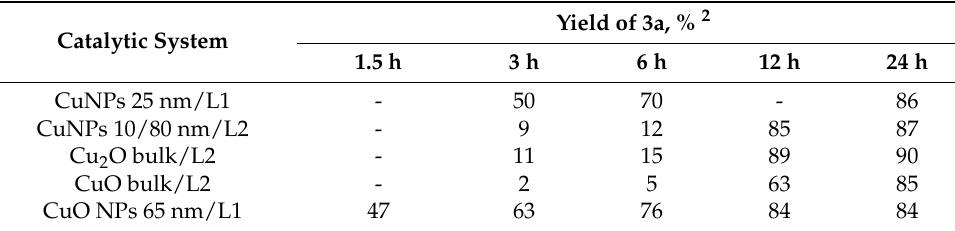
Table 6. Copper-catalyzed arylation of n -octylamine ( 1 ) with iodobenzene ( 2a ) at time intervals 1 . Yield of 3a, % Catalytic System